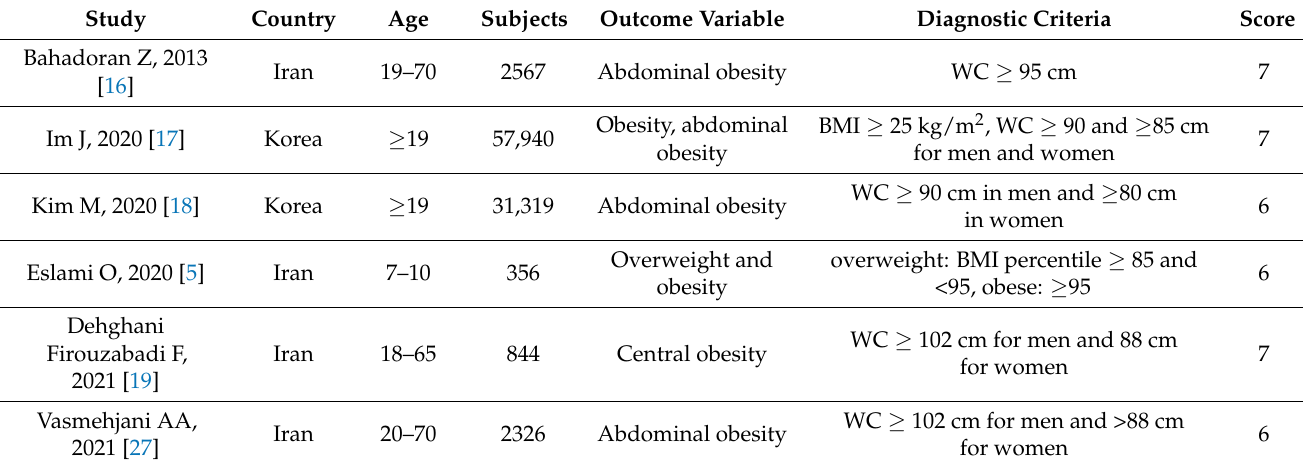
Table 1. Characteristics of the studies included.